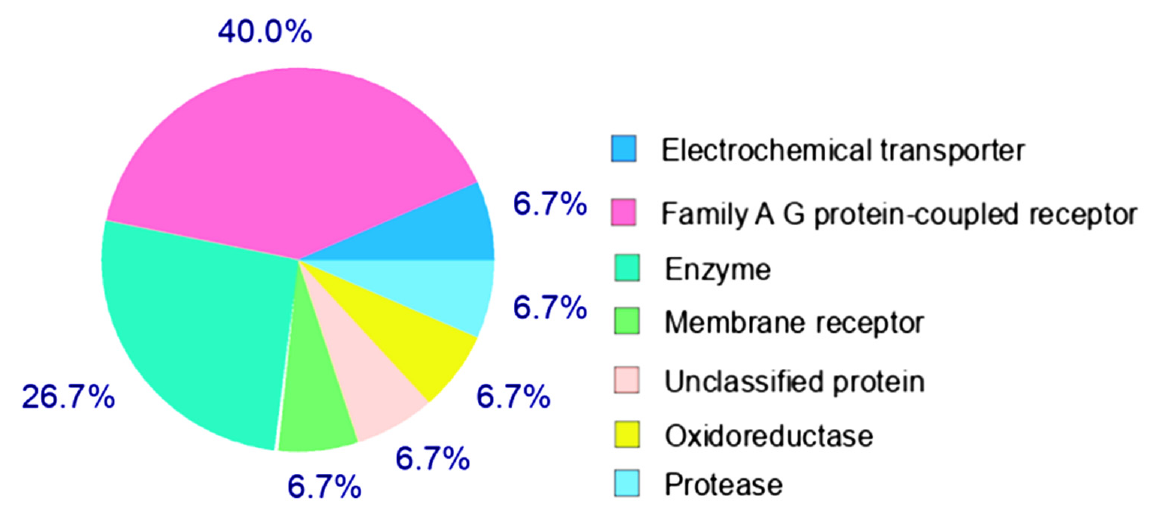
Figure 15. Pie chart showing classification of the potential molecular targets for compound 16g .